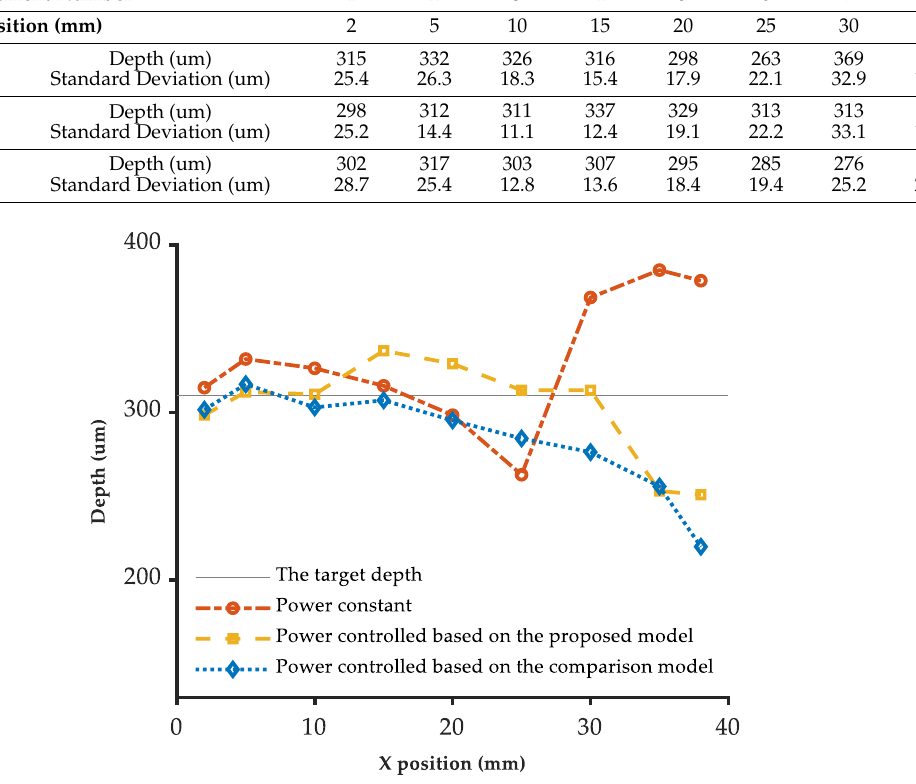
Figure 11. The normal depth results of the variable-angle straight groove.